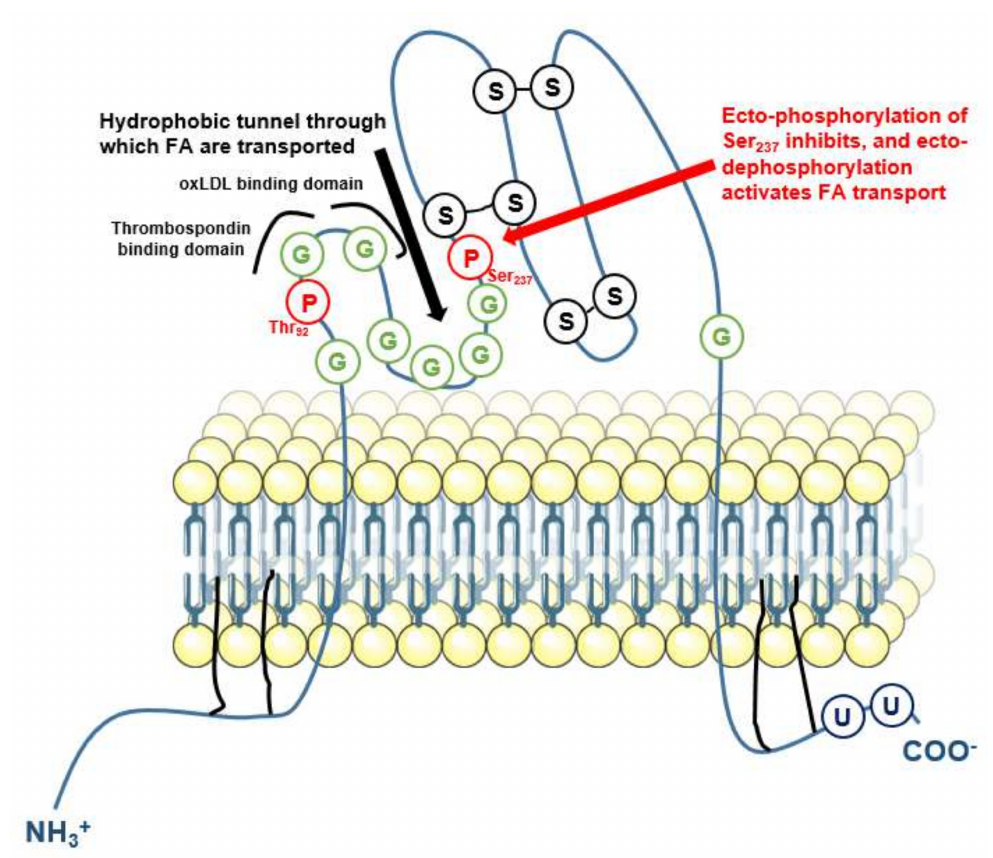
Figure 3. Schematic representation of CD36, showing its intracellular, transmembrane, and extracellular domains including posttranslational modification sites [47]. G: glycosylation sites (CD36 glycosylation is permanent and necessary for proper protein folding); P: phosphorylation site; S: cysteine involved in a disulfide bond; U: ubiquitination